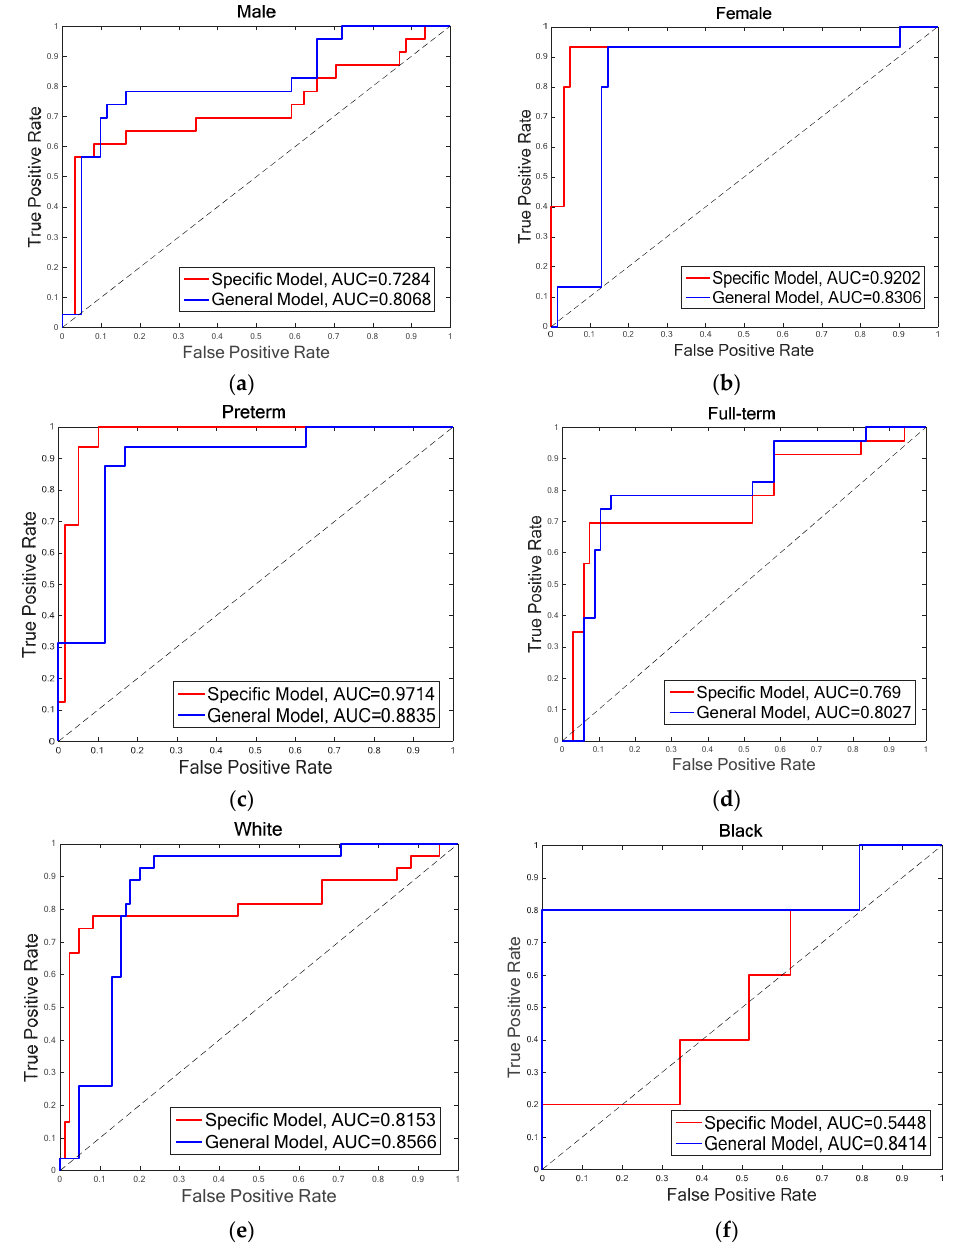
Figure 5. ROC curves for different individual groups with FDL ( a ) Male ( b ) Female ( c ) Preterm ( d ) Full-term ( e ) White ( f ) Black.